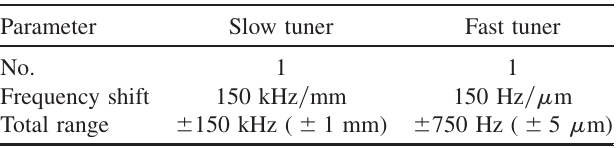
TABLE II. Frequency shift and total range of the fast and slow bellow tuner.